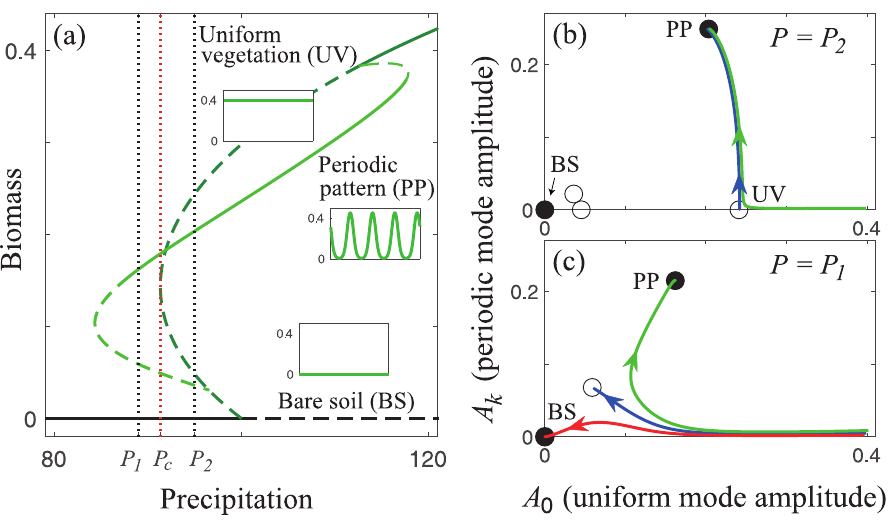
Fig 1. Managing grazing in grasslands. (a) A partial bifurcation diagram obtained from Eq (1), where solid (dashed) lines represent stable (unstable) states. The diagram shows three states: bare soil (black line, BS), uniform vegetation (dark green line, UV), and periodic vegetation pattern (light green line, PP). The insets show spatial biomass distributions of these three states. The uniform vegetation state disappears in a saddle-node bifurcation (fold bifurcation) at precipitation P . (b,c) Phase space spanned by the self-organized (SO) variables A 0 and A at c k precipitation P 2 > P c and at P 1 < P c , respectively. Solid (open) circles represent stable (unstable) states. They correspond to the intersection points of the black vertical dotted lines in panel (a) with the various solution branches. The lines in blue represent invariant manifolds (stable or unstable) associated with two saddle points . At P = P 2 , where unstable uniform vegetation states still exist (two open circles on the horizontal axis in panel b), phase trajectories that emanate from a nearly uniform-vegetation state converge to a periodic pattern (green line in panel b). By contrast, at P = P 1 , where uniform vegetation states no longer exist, phase trajectories collapse to bare soil (red line in panel c). However, introducing a small component of the periodic mode A to the initial uniform state, which may represent k non-uniform grazing, results in convergence to periodic pattern (green line in panel c). Units: precipitation [mm/yr], biomass and SO variables A 0 and A [kg/m 2 ]. k